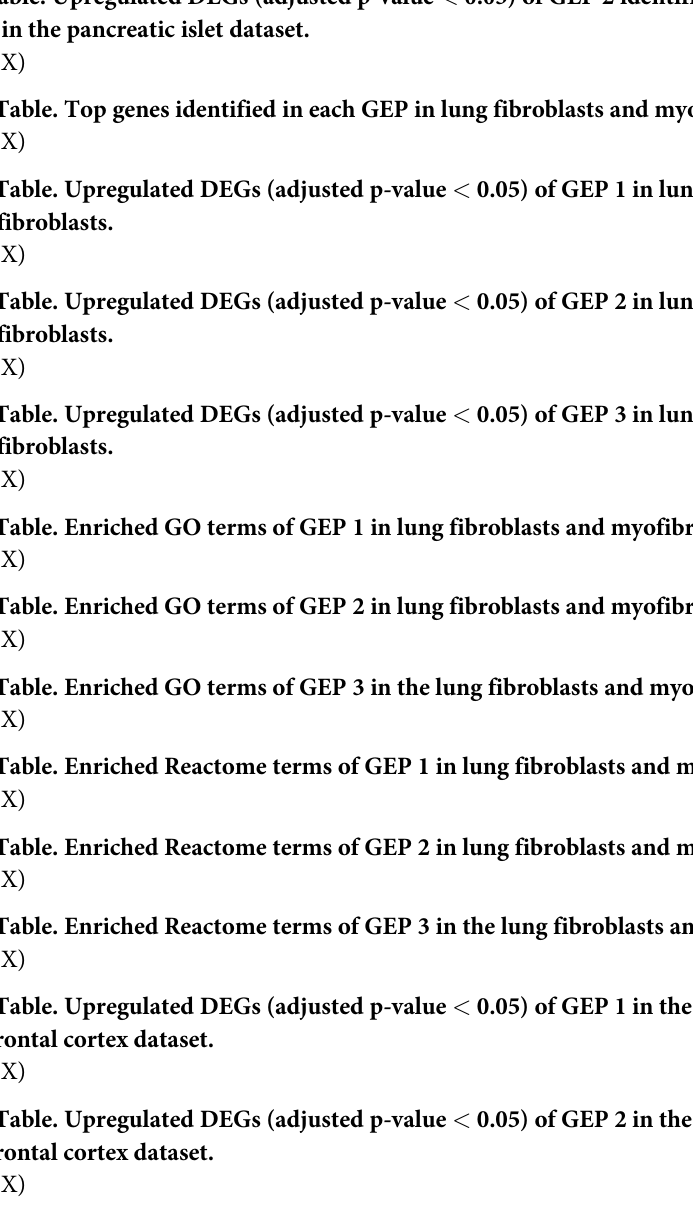
S5 Table. Enriched GO terms of GEP 7 in the pancreatic islet dataset. (XLSX) S6 Table. Enriched Reactome terms of GEP 2 in the pancreatic islet dataset. (XLSX) S7 Table. Enriched Reactome terms of GEP 7 in the pancreatic islet dataset. S8 Table. Upregulated DEGs (adjusted p-value < 0.05) of GEP 1 identified only using beta cells in the pancreatic islet dataset. S9 Table. Upregulated DEGs (adjusted p-value < 0.05) of GEP 2 identified only using beta cells in the pancreatic islet dataset. S10 Table. Top genes identified in each GEP in lung fibroblasts and myofibroblasts. S11 Table. Upregulated DEGs (adjusted p-value < 0.05) of GEP 1 in lung fibroblasts and myofibroblasts. S12 Table. Upregulated DEGs (adjusted p-value < 0.05) of GEP 2 in lung fibroblasts and myofibroblasts.